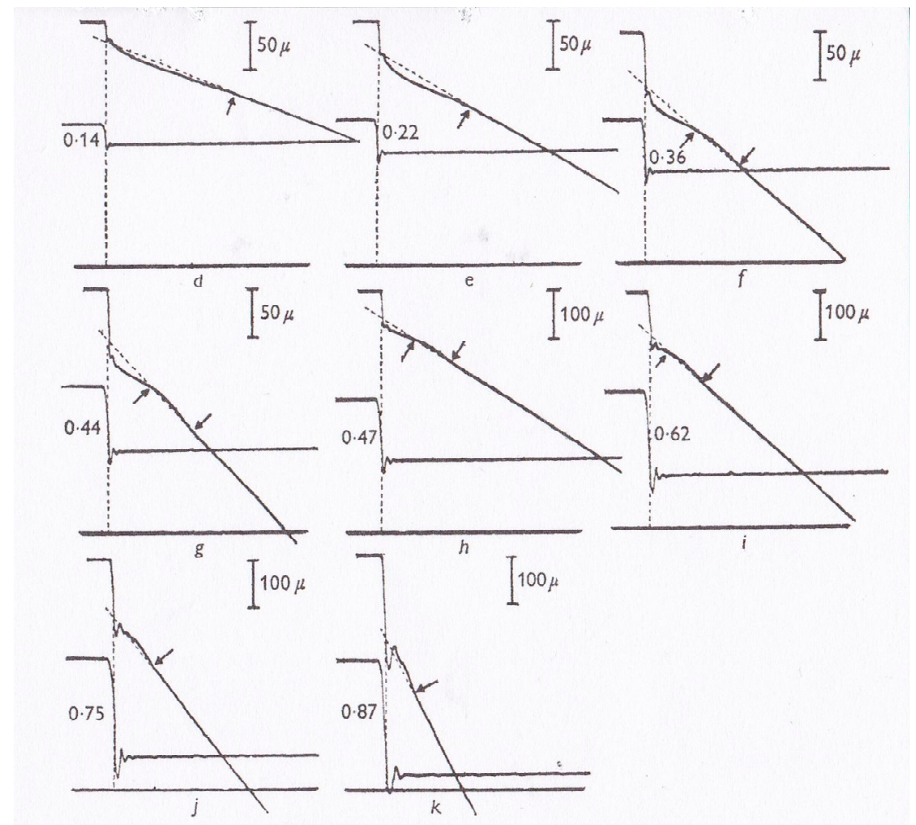
Figure 6. Transient oscillatory changes in shortening velocity (isotonic velocity transient) in tetanized single intact frog muscle fibers following various magnitudes of quick changes in load from Po to P < Po. Changes in fiber length and force are shown in upper and lower records, respectively. From Ref.